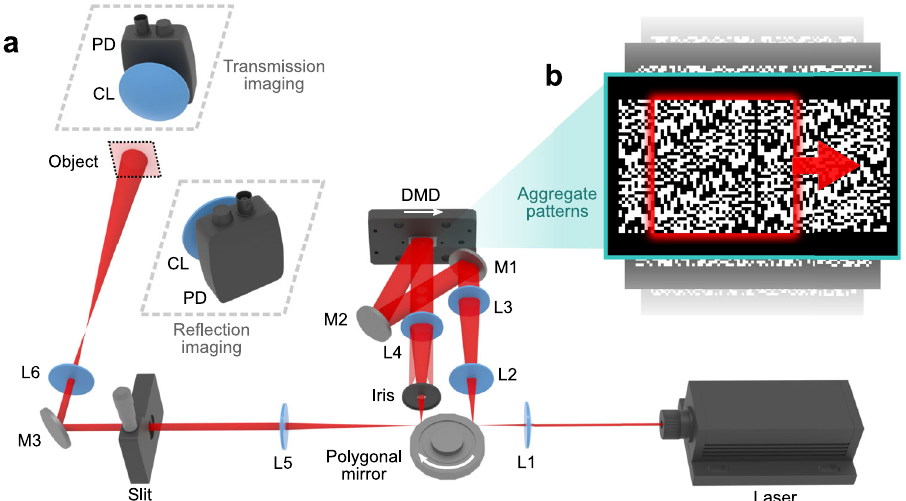
Fig. 1 | Schematic of SPI-ASAP. a System illustration showing beam scanning of a DMD-displayed aggregate pattern by rotation of a polygonal mirror. White arrows indicate directions of polygonal mirror rotation and illumination scanning. CL, condenserlens;DMD,digitalmicromirrordevice;L1-L6,lenses;M1-M3,mirrors;PD,